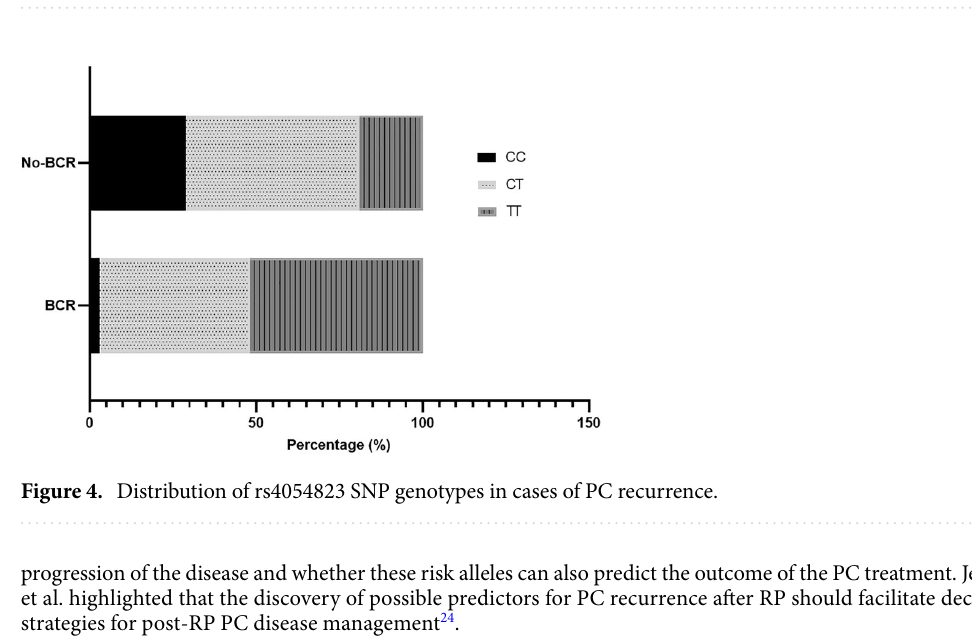
Figure 3. Kaplan–Meier survival curves of recurrence-free survival after RP according to 17p12 rs4054823 genotypes (TT vs CC/CT).